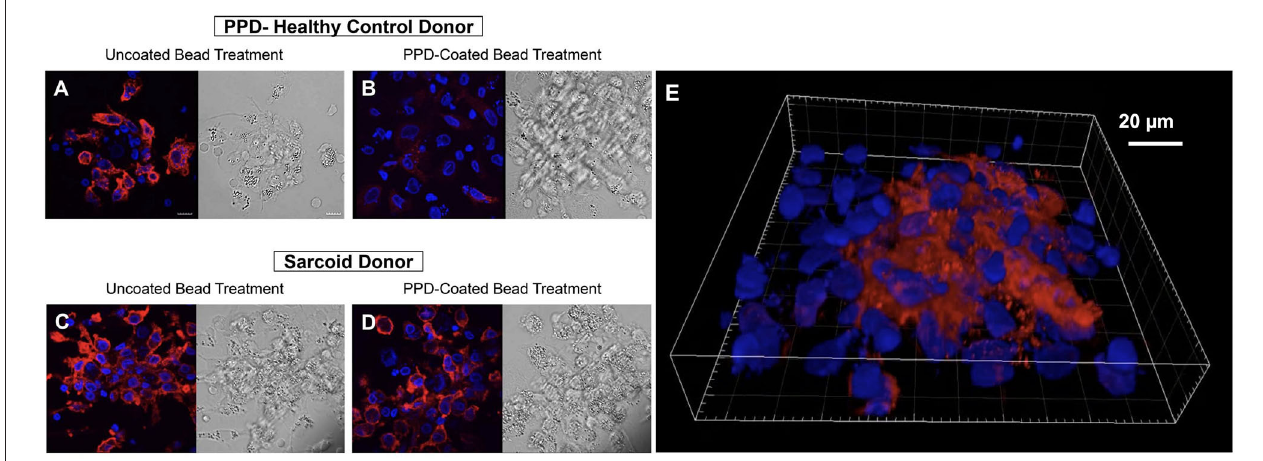
FIGURE 5 | CD163 expression is increased in granuloma-like structures formed by antigen-stimulated sarcoidosis PBMCs in the in vitro human granuloma model. Immunofluorescence microscopy imaging demonstrating macrophage CD163 expression upon stimulating healthy control PBMCs with uncoated beads (A) with dramatic loss of expression following 7-days M.tb antigen-stimulation (B) . In contrast, abundant CD163 expression was observed on sarcoidosis macrophages after uncoated bead treatment (C) that persisted after M.tb antigen-stimulation (D) . A 3D rendered volume of a sarcoidosis granuloma-like structure 7 days after M.tb antigen-stimulation showing centrally clustered CD163-expressing macrophages (E) . DAPI and CD163 staining shown in blue and red,